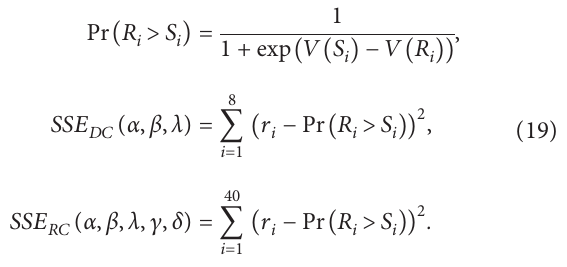
the final results of the model parameter calibration. The parameter estimates are { α � 0.39, β � 0.36, λ � 1.48} and { α � 0.13, β � 0.48, λ � 1.31, c � 0.68, δ � 0.22}, for deter- ministic and risky conditions,